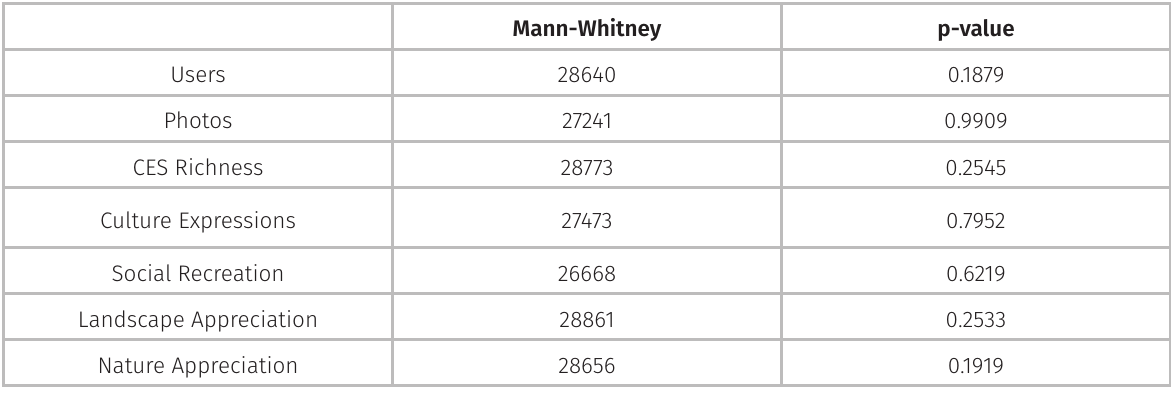
Table II. Summary results of pair comparison with Mann-Whitney U test before and during the oil